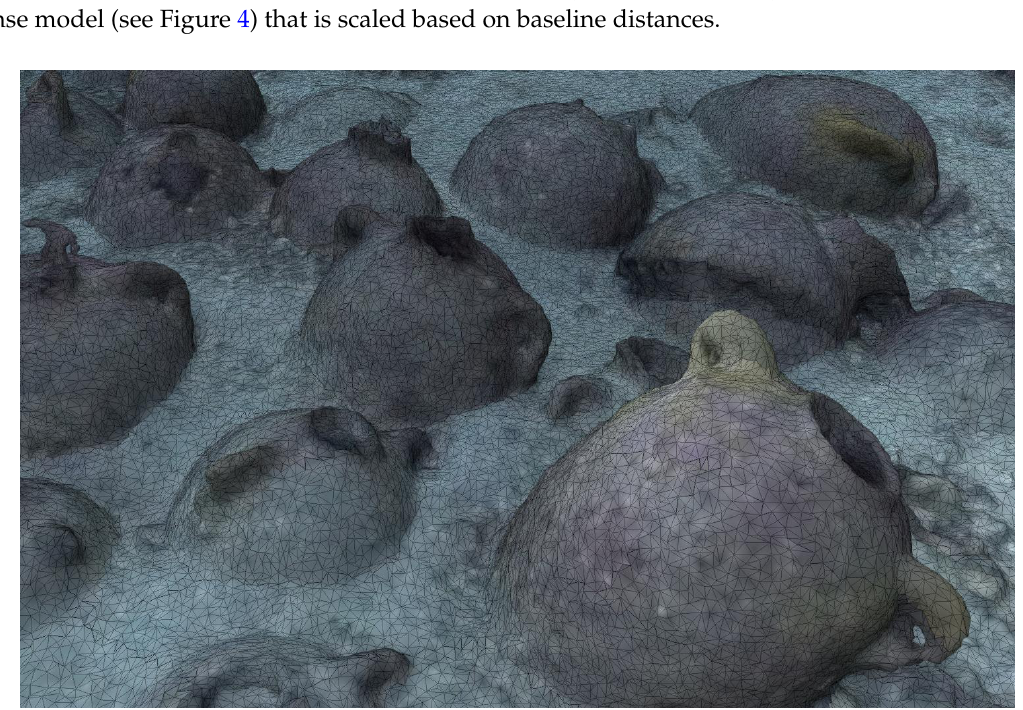
Figure 4. A snapshot of the 3D survey at low resolution for web display through skechfab , available on the GROPLAN website (http://www.groplan.eu).